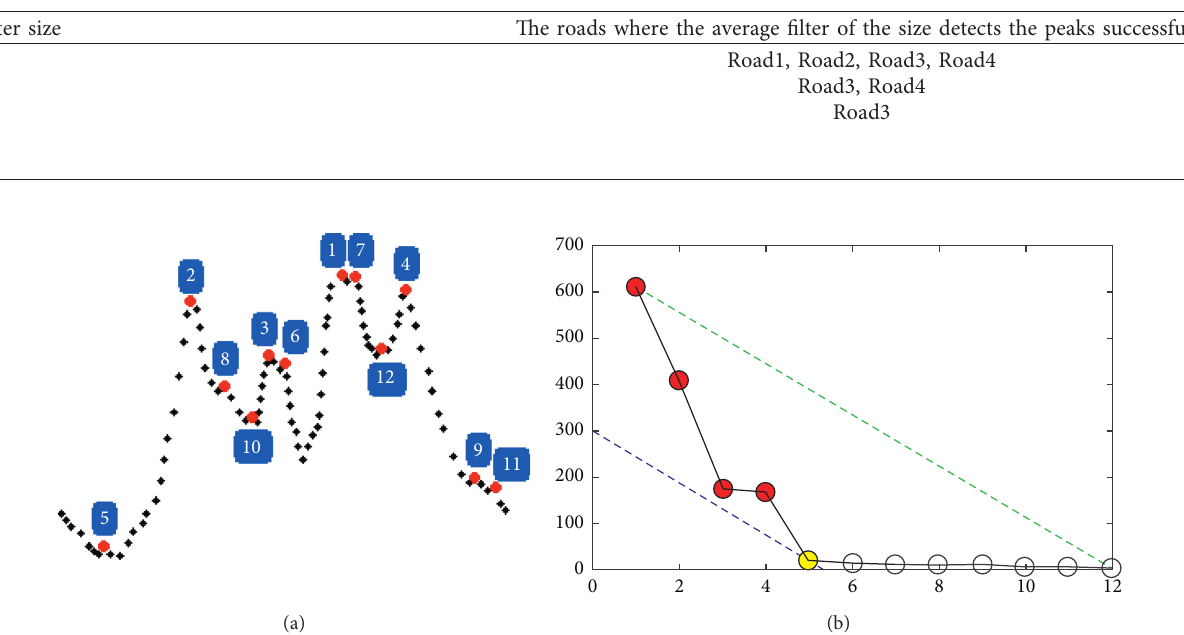
Table 1: The results of the average filter of different sizes.